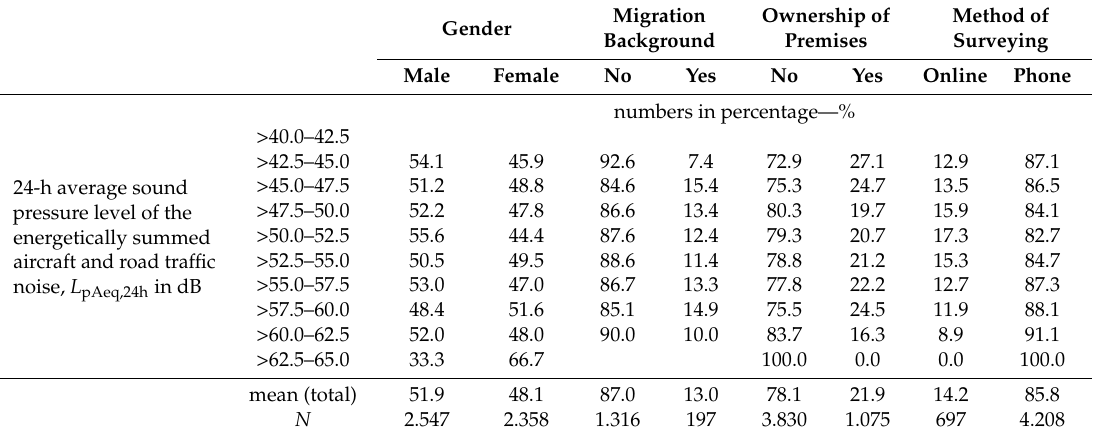
Table 2. Distribution of relevant covariates per 2.5 dB sound classes of the 24-h average sound pressure level of the energetically summed aircraft and road traffic noise, L pAeq,24h